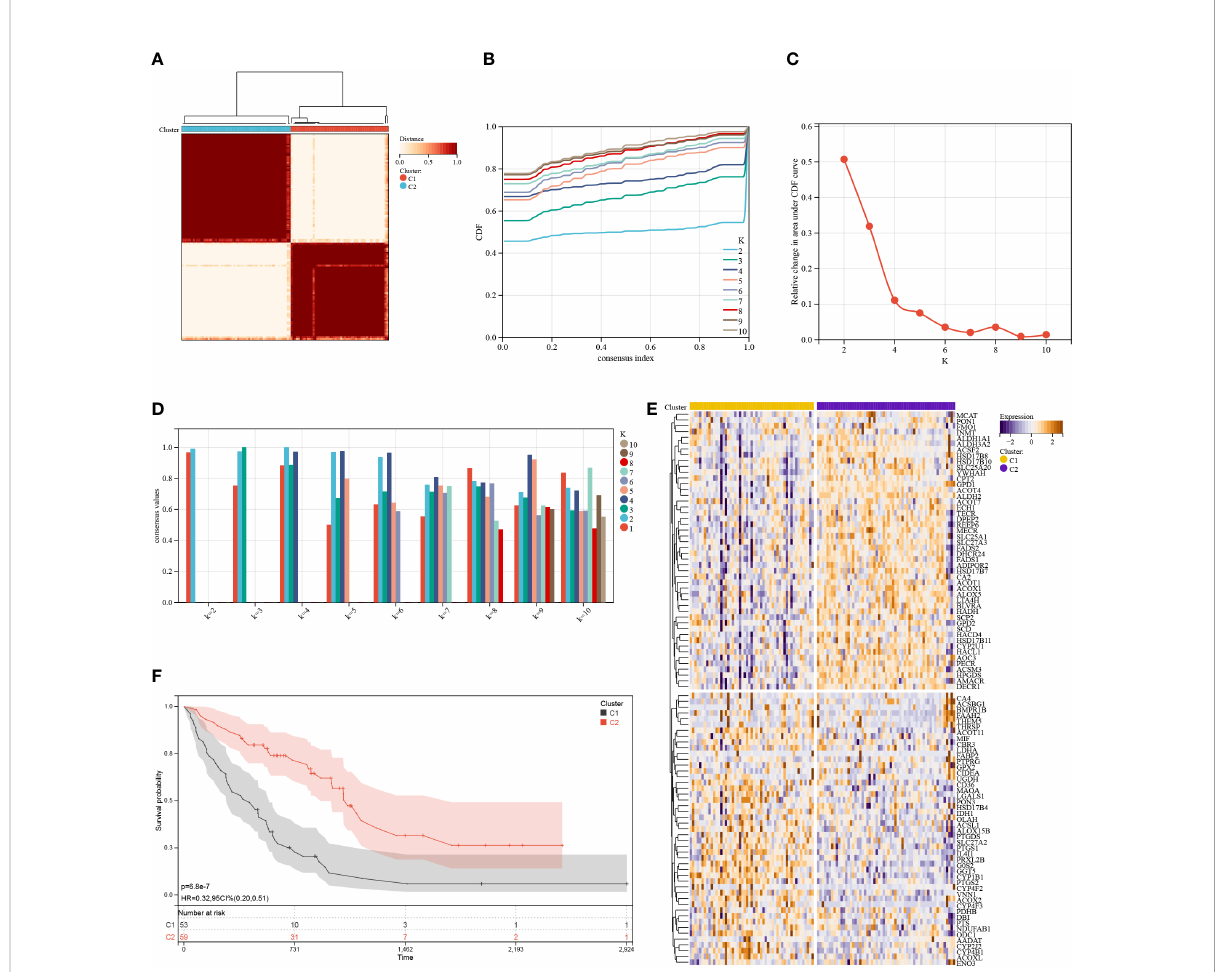
FIGURE 3 Consensus cluster. (A – D) : K = 2 was identi fi ed as the optimal value for consensus clustering. (E) Heatmap shows the expression of fatty acid metabolism-related genes in the two clusters. (F) Survival curve of the patients in the two